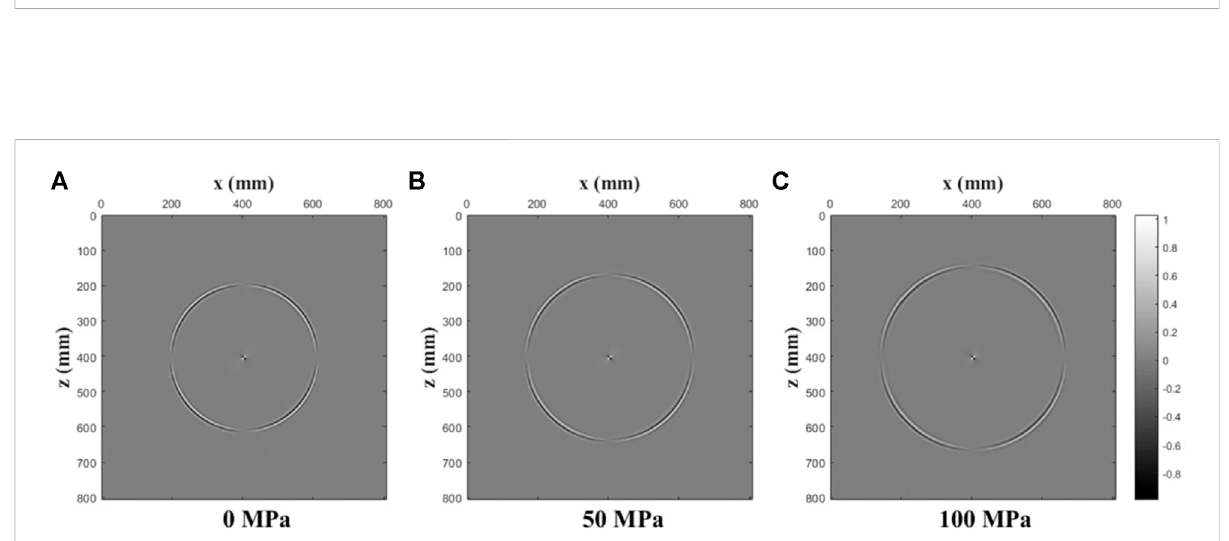
FIGURE 4 Decoupled S-wave fi eld snapshots of the x -component of the particle velocity at t = 0.1 ms for various con fi ning stresses. ( (A) : 0 MPa; (B) : 50 MPa; (C) : 100 MPa).